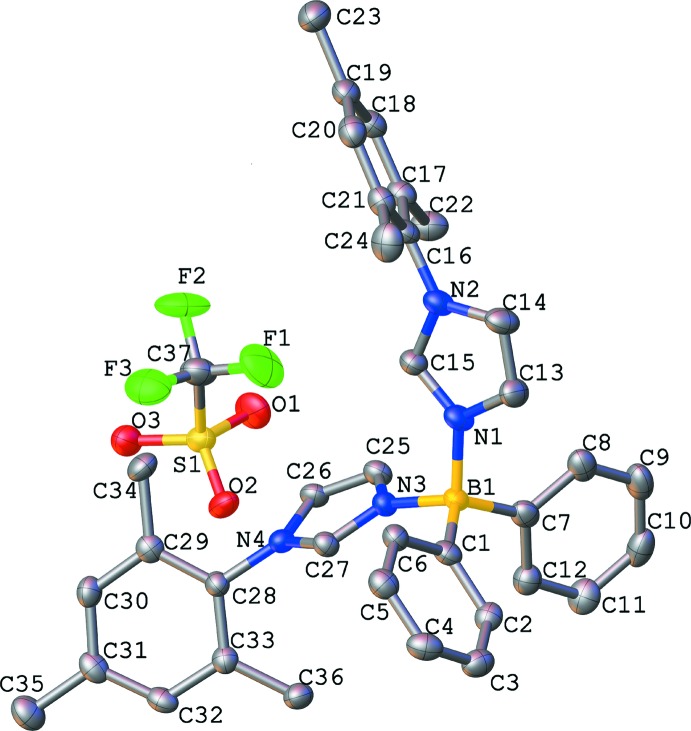
Mol­ecular structure of Ph2B(MesIm)2OTf with atom labels. Displacement ellipsoids are shown at the 50% probability level. Hydrogen atoms are omitted for clarity.